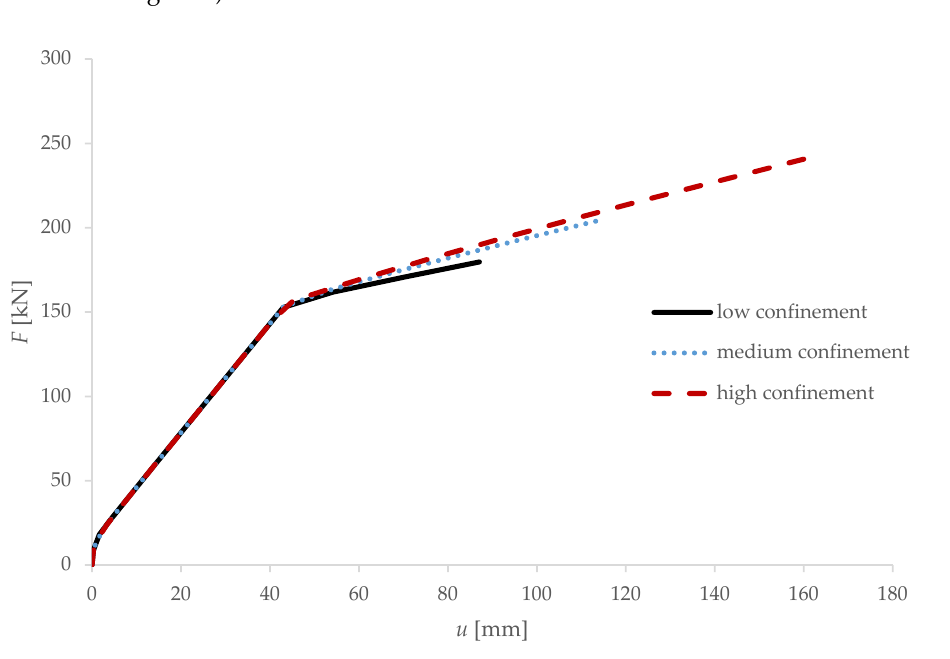
Figure 7. Force–deflection diagram for three different levels of confinement. Influence of confinement on the ductility of an element is shown in Figure 8.